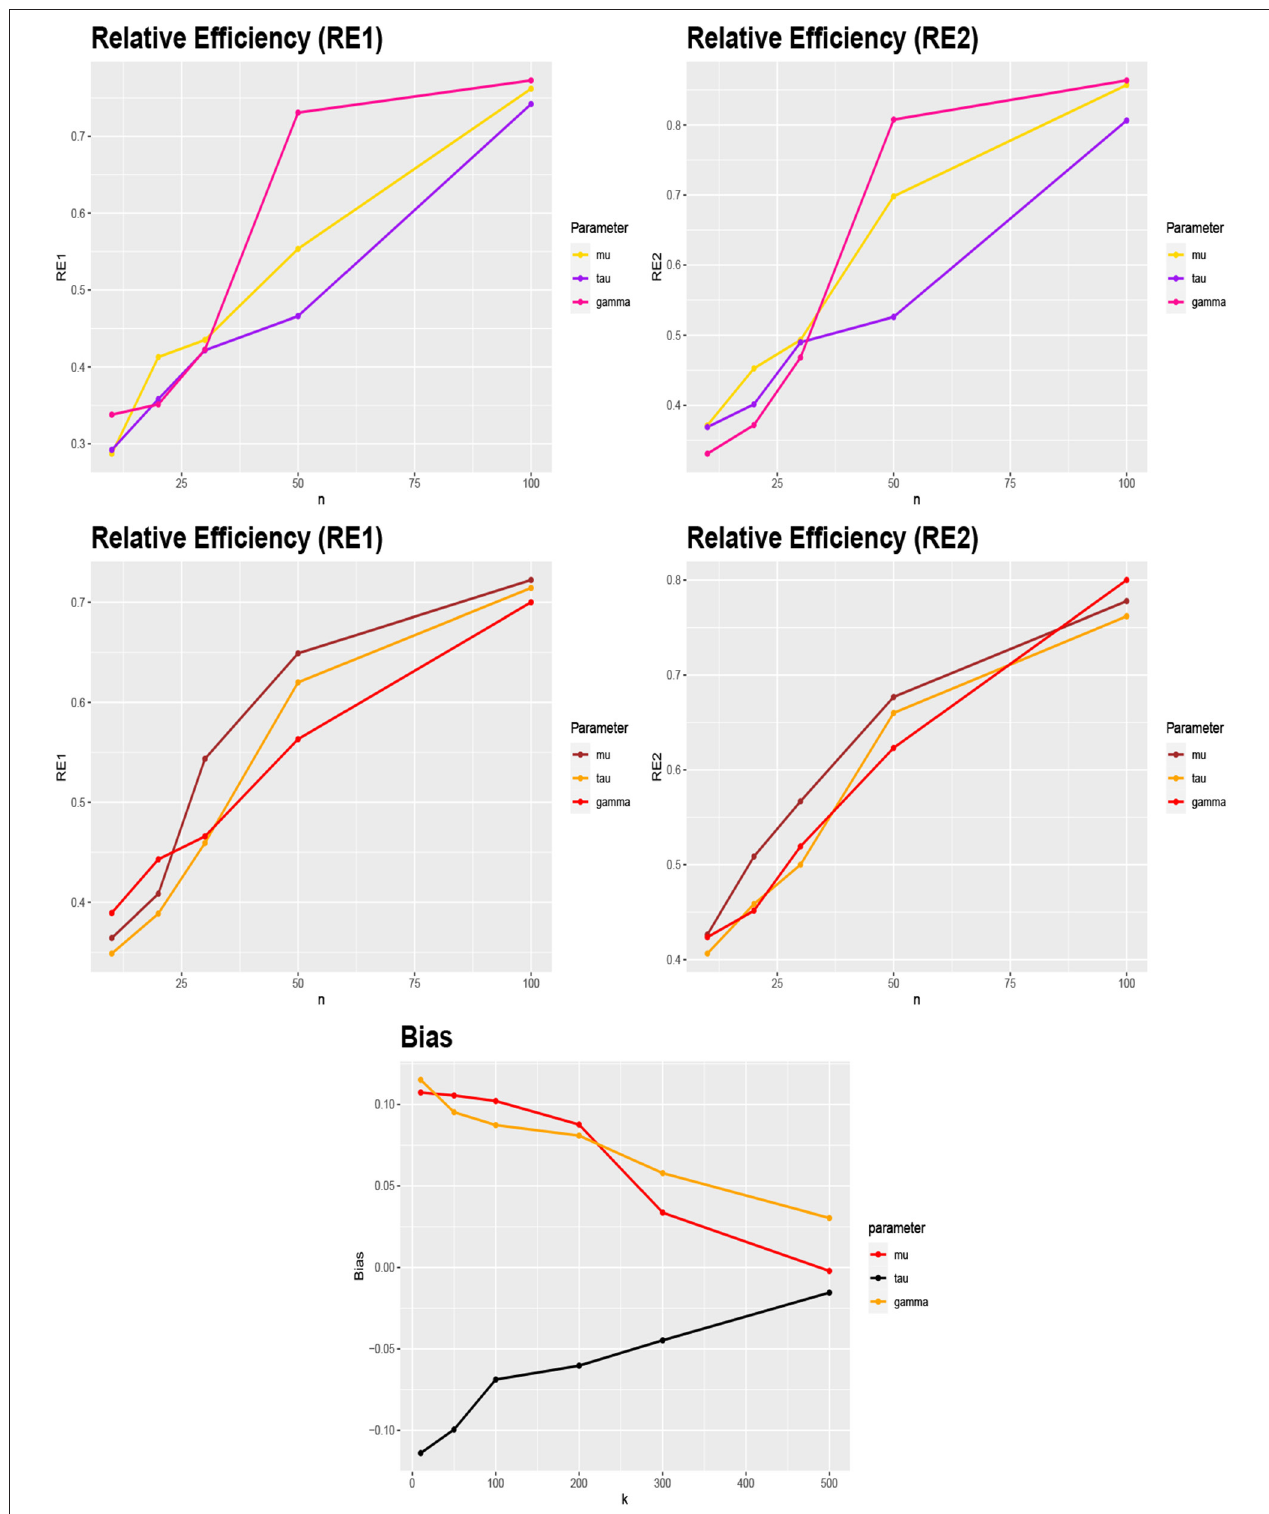
FIGURE 5 | (Top) the RE of the Bayes estimates and MLEs of µ , τ , and γ vs. the sample size n for scenario 2. (Middle) the RE of the Bayes estimates and MLEs of µ , τ , and γ vs. the sample size n for scenario 3. (Bottom) the biases of the Bayes estimates of ( µ , τ , γ ) under the squared error loss function for scenario 3, p n 100 and different values of k 10,50,100,200,300,500. = =